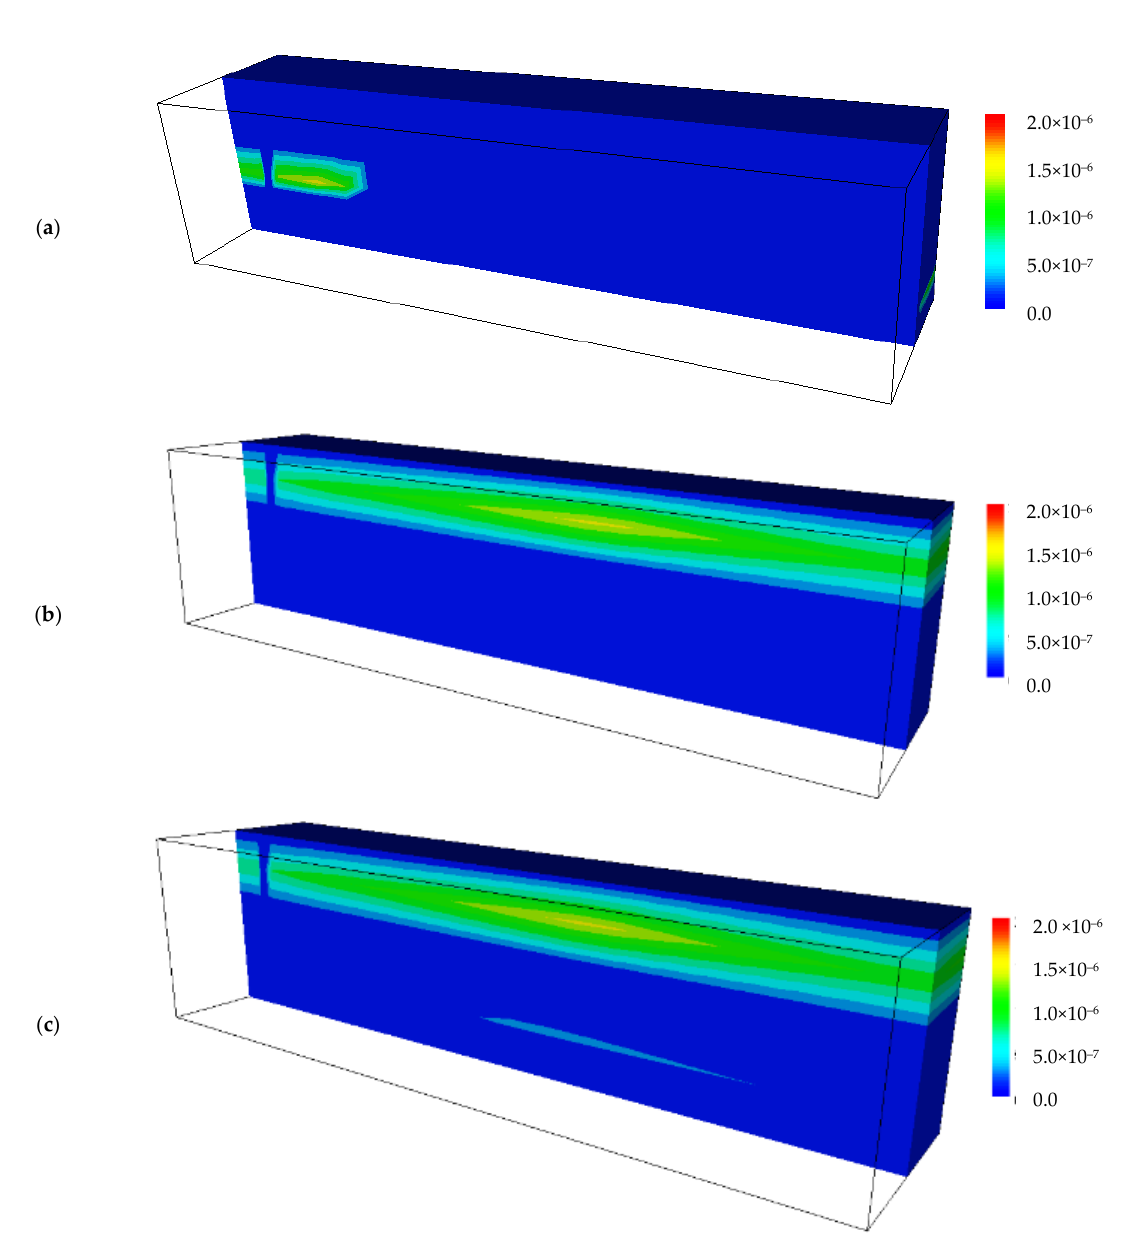
Figure 8. Distribution of precipitated Fe(OH) 3 (mol/L) at t = 50 years: ( a ) case 1, ( b ) case 2-1, and ( c ) case 2-2.